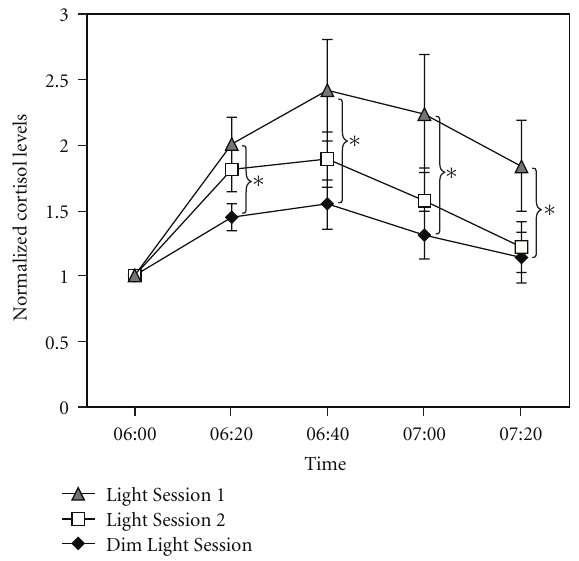
Figure 2: Normalized morning cortisol levels during the Dim Light Session and during the two blue light exposure sessions. All data were normalized to levels gathered at the first, common experimental sampling time of 6:00 AM, which was the time of awakening. Shown are the mean ± SEM normalized cortisol levels for each experimental condition and sample collection time; normalized cortisol levels during blue light exposures that were significantly di ff erent than those during dim light are indicated with